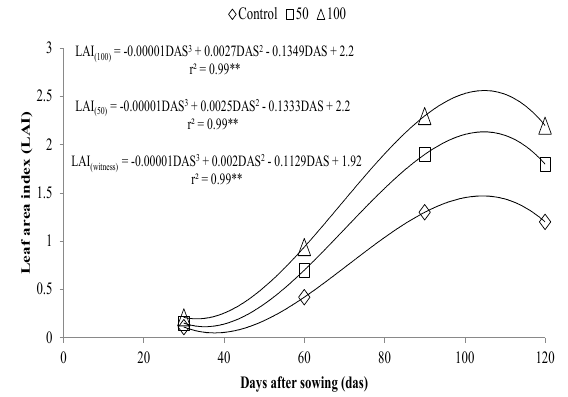
Figure 2 . Dynamics of the sunflower leaf area index ( Helianthus annuus L.) at 30, 60, 90 and 120 das, under three levels of potassium. Universidad Tecnológica de Tehuacán. Summer,